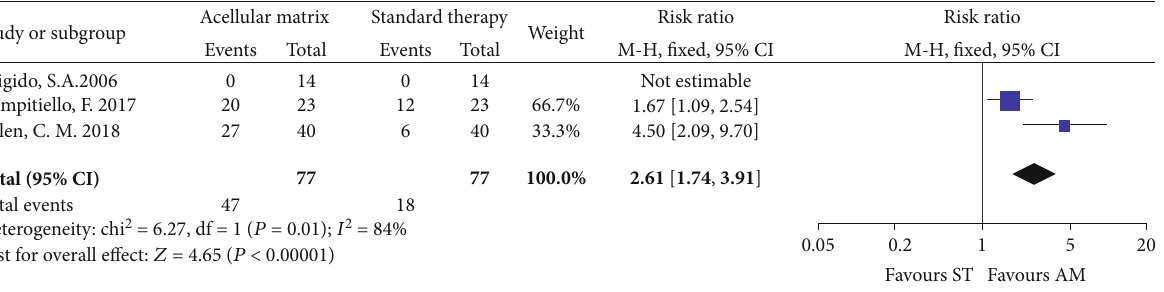
Figure 5: Forest plot of complete healing rate at 6 weeks.